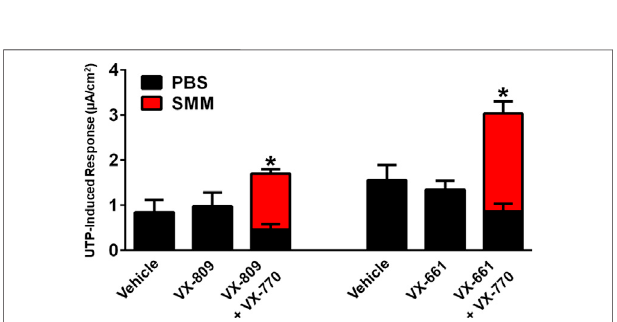
FIGURE 3 | SMM overcomes chronic VX-770 treatment-promoted inhibition of UTP-induced responses. F508del/F508del HBE cultures were exposed for 48 h to vehicle or 5 µM VX-809 or VX-661 ± 5 µM VX-770 in combination with PBS or SMM. Data are expressed as mean ± SEM. * p < 0.05; n (cid:2) 3 F508del/F508del HBE culture donors, experiments were performed in three